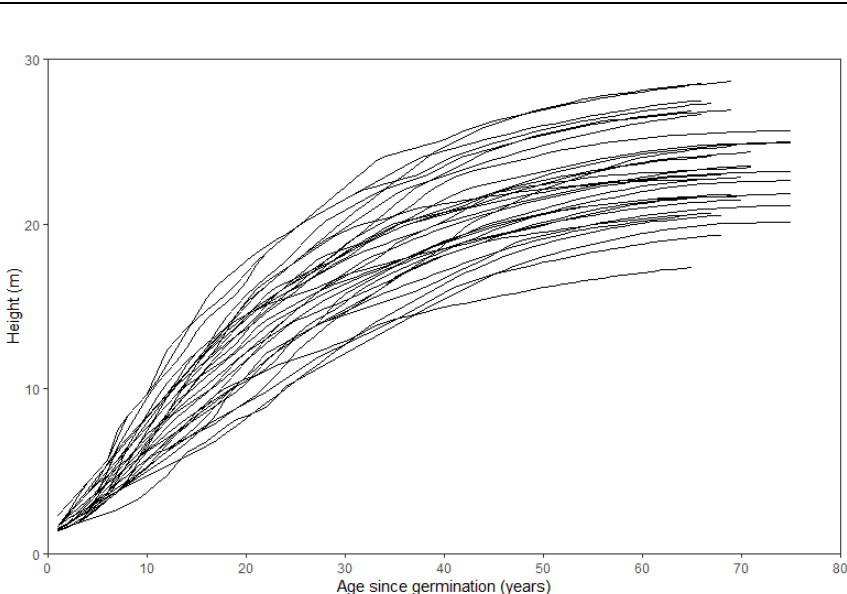
Figure 2. Stem analysis (SA) growth trajectory data extracted from 75 dominant trees chosen in the 29 Larix stands. Table 1. Distribution of dominant larch trees in different site